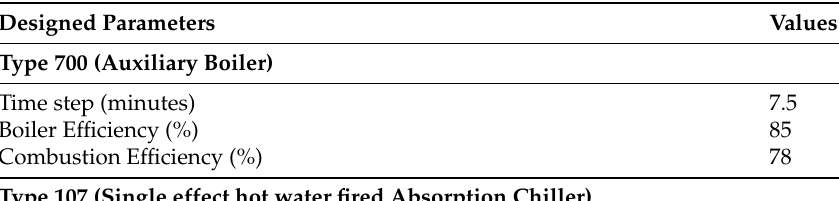
Table 2. Design parameters for solar absorption cooling